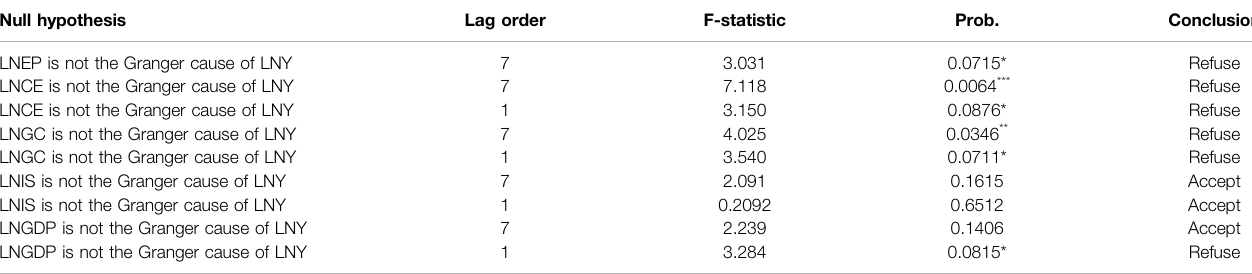
TABLE 8 | Granger causality test